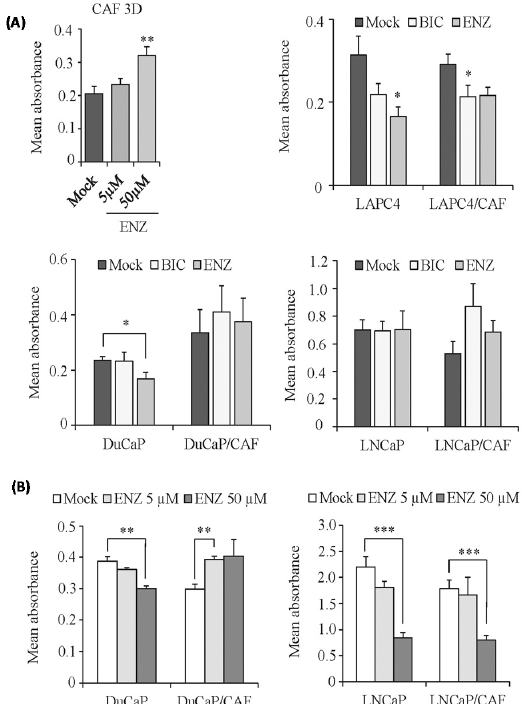
Figure 6. Effects of anti-androgens on prostate cancer spheroid growth. ( A ) CAF 3D spheroids were treated with 5 or 50 μ M enzalutamide over 10 days. PCa monoculture and PCa/CAF co-culture spheroids were treated with bicalutamide (BIC) and enzalutamide (ENZ) at a final concentration of 5 μ M in standard culture medium containing 10% FCS. Treatment was started at day 4 when spheroids were visible. Cell viability was determined after 10 days of treatment via WST-1 assay and expressed as mean absorbance; ( B ) LNCaP, DuCaP monoculture, and LNCaP/CAF, DuCaP/CAF co-culture spheroids were treated with 5 and 50 μ M enzalutamide (ENZ) over 10 days and cell viability was measured via WST-1 assay. Values denote mean absorbance plus SEM ( n = 3). * p < 0.05; ** p < 0.01; *** p < 0.001.